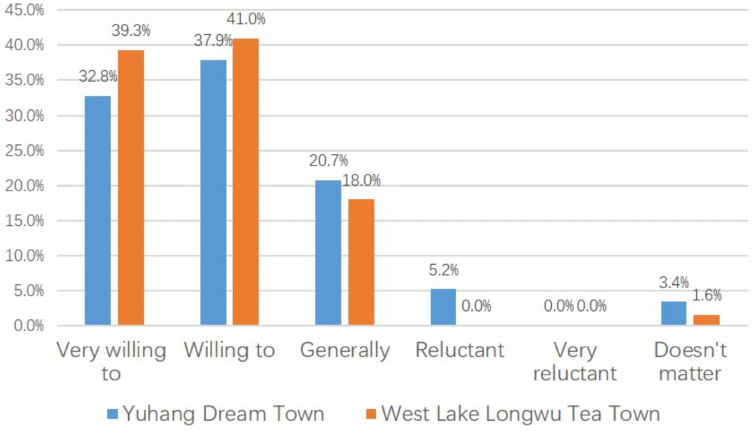
Figure 39. Respondents’ willingness to support various development activities of local CTs in the future (source: